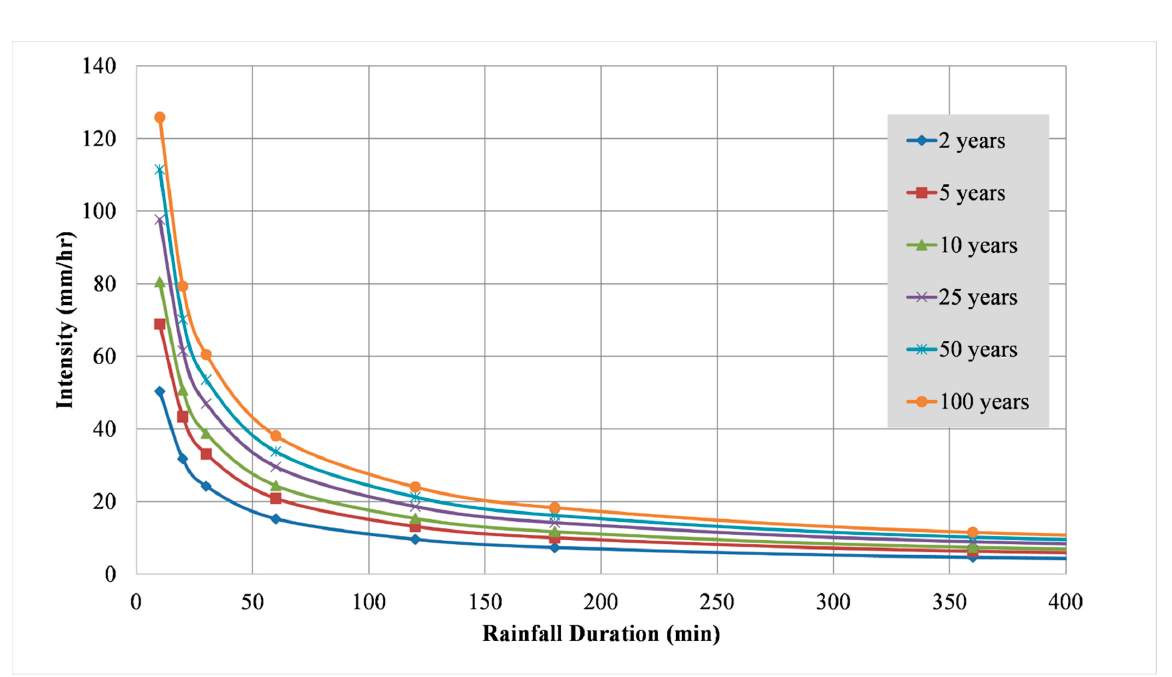
Figure 6. IDF curves generated using the LPT III method on an ordinary scale.